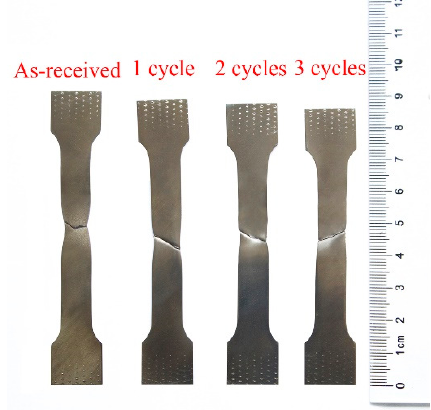
Figure 9. Macroscopic fractural morphology of CP Ti.